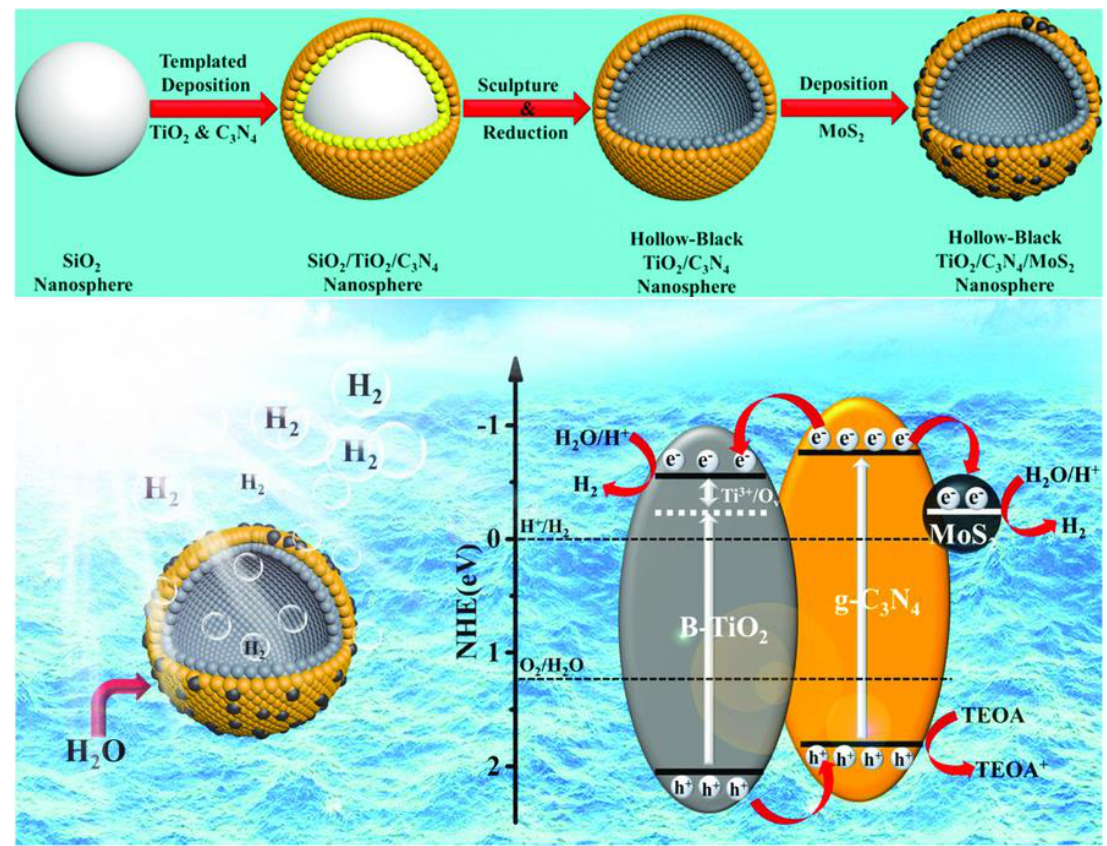
Figure 11. Process diagram of the preparation and photocatalytic hydrogen evolution reaction (HER) mechanism of the MoS 2 QDs modified black Ti 3+ –TiO 2 /g–C 3 N 4 hollow nanosphere heterojunction. Reproduced from [150] . Copyright (2019), Wiley-VCH Verlag GmbH & Co. KGaA, Weinheim.